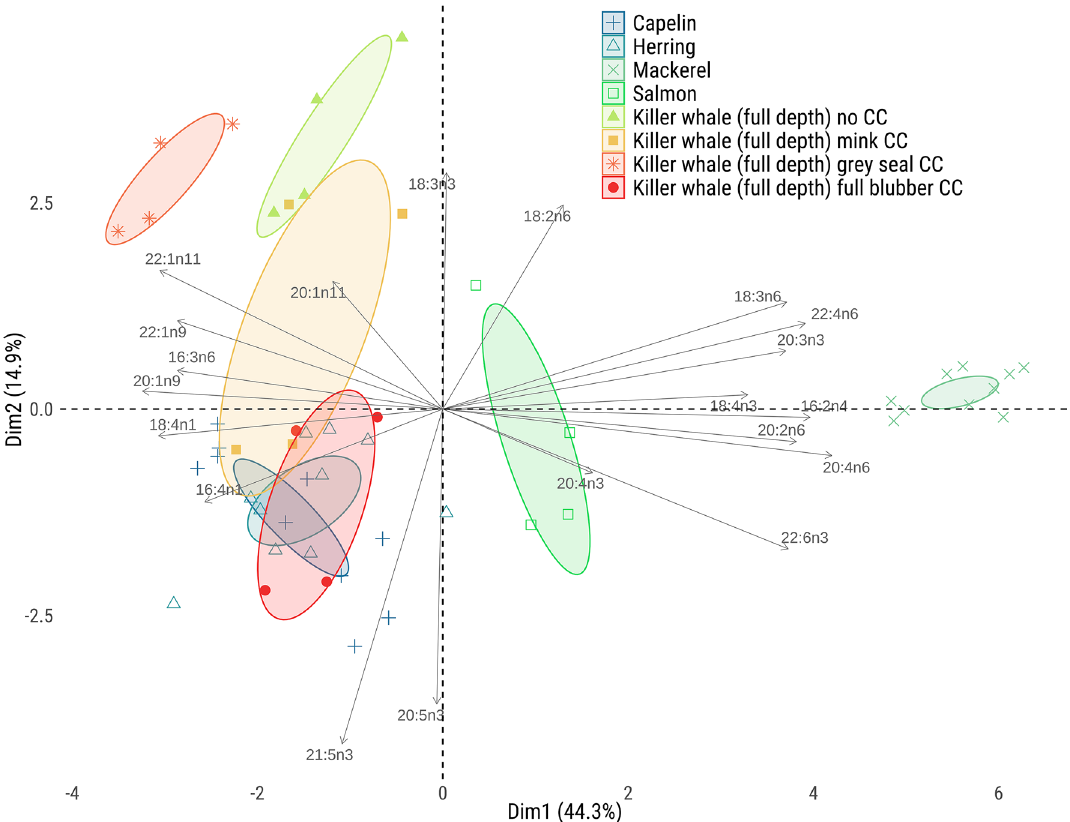
Figure 2. Principal component analysis (PCA) of dietary FA signatures in prey species, as well as in managed- care killer whales without CCs, with previously published mink and grey seal CCs, and with killer whale CCs generated for this study. Applying killer whale CCs to the predator moved their FA signatures within the ranges of the prey FA signatures ( i.e .: capelin and herring when using the Aitchison distance: 21.7% error (KL) vs. 22.1% (Aitchison) for full blubber FA signatures with full blubber CCs; 16.8% error vs. 29.8% error for the inner blubber FA signatures with inner blubber CCs; and 25.7% error vs. 32.1% error for outer blubber FA signatures with outer layer CCs (Tables S8 and S9). Both the Aitchison and KL distances scored a high correct attribution rate of the prey to its species (an average of 91.0% for the Aitchison distance vs. 84.4% for the KL distance), and results were too close to determine which LOPO analysis performed better (Table S4). The diet of the managed-care killer whales was accurately estimated using killer whale CCs, provided that the appropriate layer-specific CC was used (e.g., inner blubber CCs to model the diet based on inner blubber FA signatures; Figs. 3 and S3). The accuracy was lower when we did not use the CC set corresponding to the FA layer (Tables S8 and S9). Indeed, while using full blubber CCs on full blubber FA signatures resulted in 21.7% error compared to the true diet, using full blubber CCs on outer blubber FA signatures resulted in 86.0% error with a large overestimation of herring (89.6% estimated vs. the true diet of 60%). Our results with the KL dis- tance showed that the inner layer average CCs yielded more accurate estimates (16.8% error) on inner blubber FA signatures compared to layer 1 CCs (50.7% error). In the same way, layer 1 CCs produced the most accurate estimates when used on layer 1 FA signatures (18.1% error vs. 48.4% error on inner blubber FA signatures), and layer 10 CCs yielded more accurate estimates when used on layer 10 FA signatures (20.2% error) than when used on outer blubber FA signatures (67.8% error). Finally, outer blubber CCs yielded good accuracy when used on the outer blubber FA signatures and on layer 10 FA signatures (25.7% error for outer blubber FA, and 33.5% error for layer 10 FA).